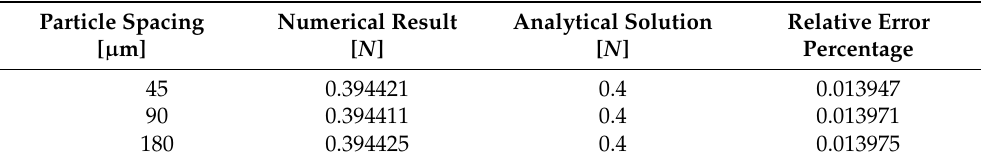
Figure 3. Profile of the volumentric Marangoni force along the normal direction to the interface using a resolution of Lo = 180 [ µ m], Lo = 90 [ µ m] and Lo = 45 [ µ m]. Table 2. Comparison between SPH results of the integrated Marangoni force and analytical